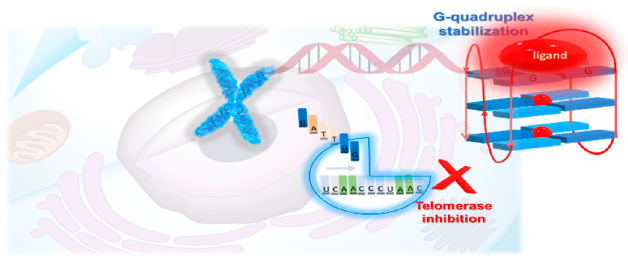
Figure 1. Indirect telomerase inhibition by G-quadruplex stabilization by Figure 17. Indirect telomerase inhibition by G-quadruplex stabilization by ligands.